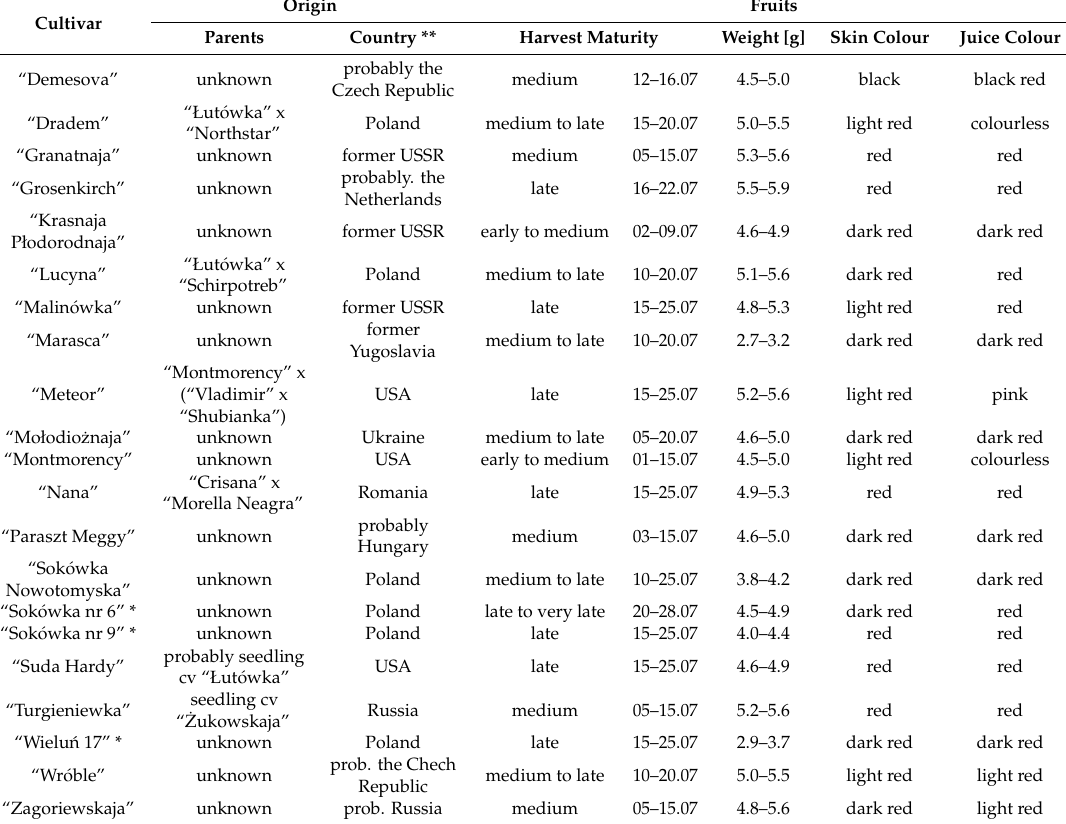
Table 6. Plant material